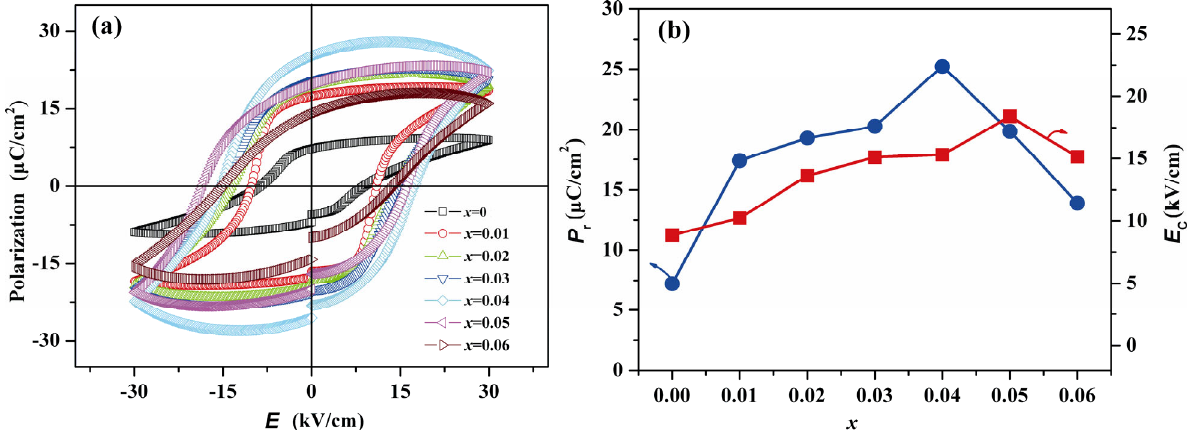
Fig. 7 P–E hysteresis loops, , and coercive field